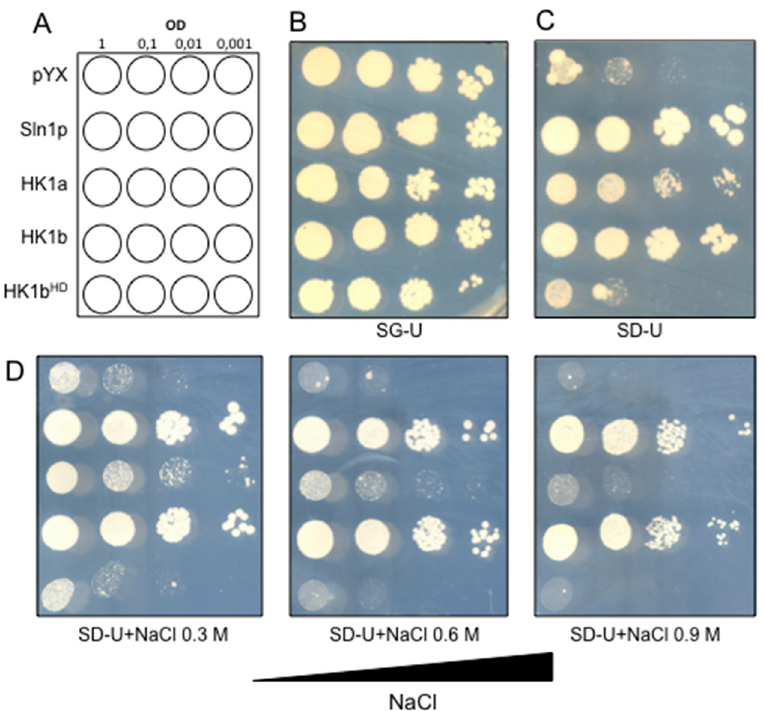
Figure 7. Functional complementation assay. ( A ) Different constructs were introduced into the osmodeficient strain (MH179) as indicated and spotted onto different media at a density corresponding to an optical density (OD) 600 = 1 and three 10-fold dilutions as indicated. The resulting transformants were spotted onto SG-Ura medium for growth control ( B ) and onto SD-Ura medium for growth rescue ( C ). Finally, transformants were spotted onto SD-Ura+NaCl media with increasing concentration of NaCl for the osmotic tolerance test ( D ).